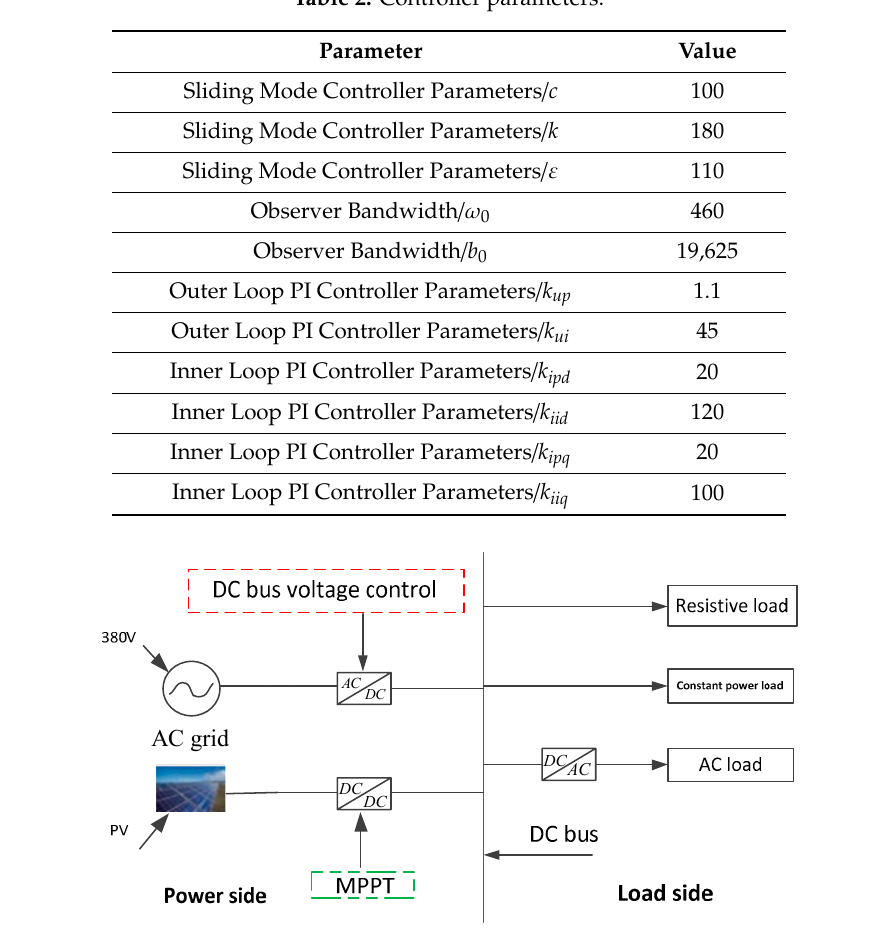
Figure 7. System Figure 7. System structure.